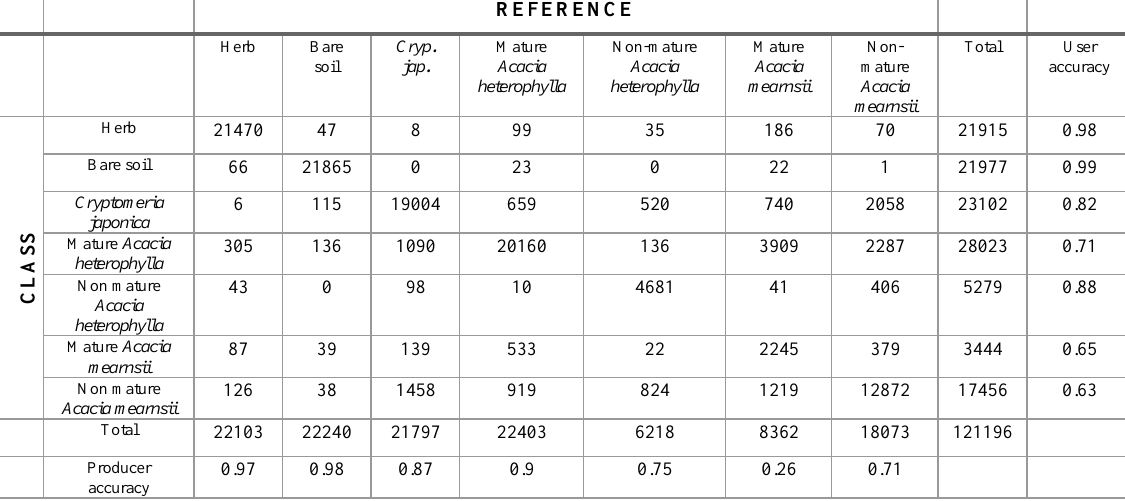
Table 2. Confusion matrix and accuracy